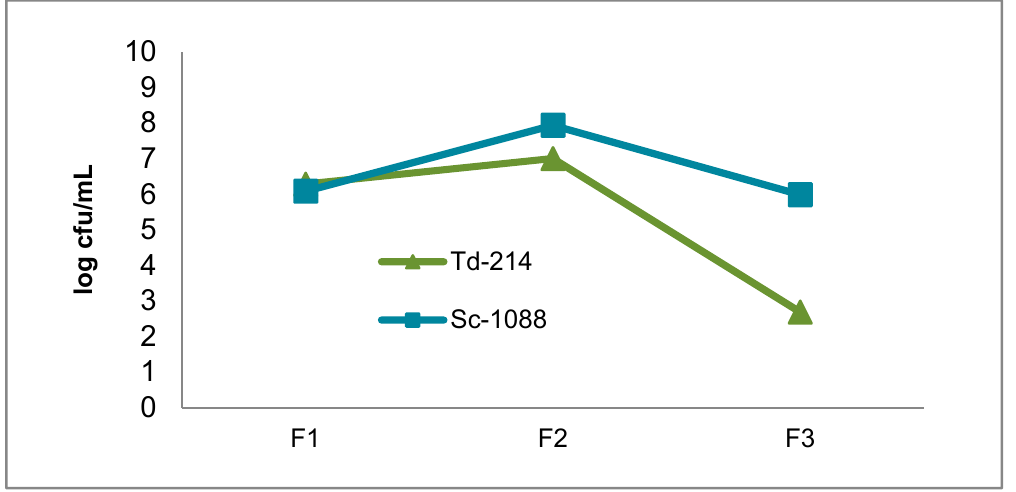
Figure 2. The growth of yeasts during mixed culture fermentation. Td-214: T. delbrueckii -214, Sc-1088: S. cerevisiae -1088. F1: beginning of fermentation. F2: middle of fermentation. F3: end of fermentation.